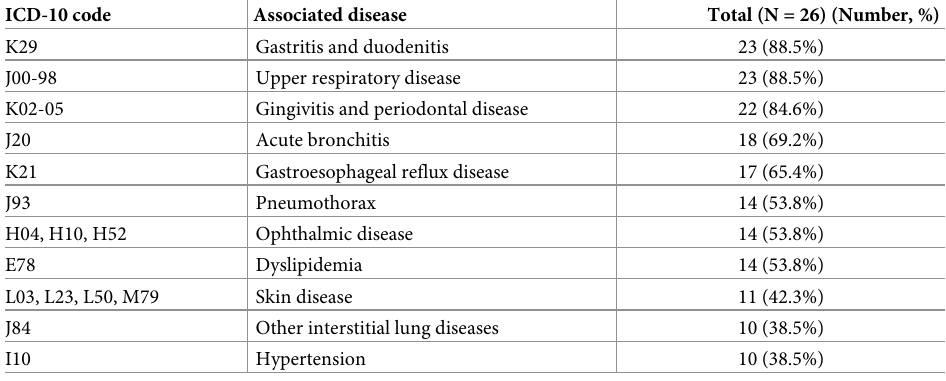
Table 3. Associated diseases before and after the diagnosis of BHD